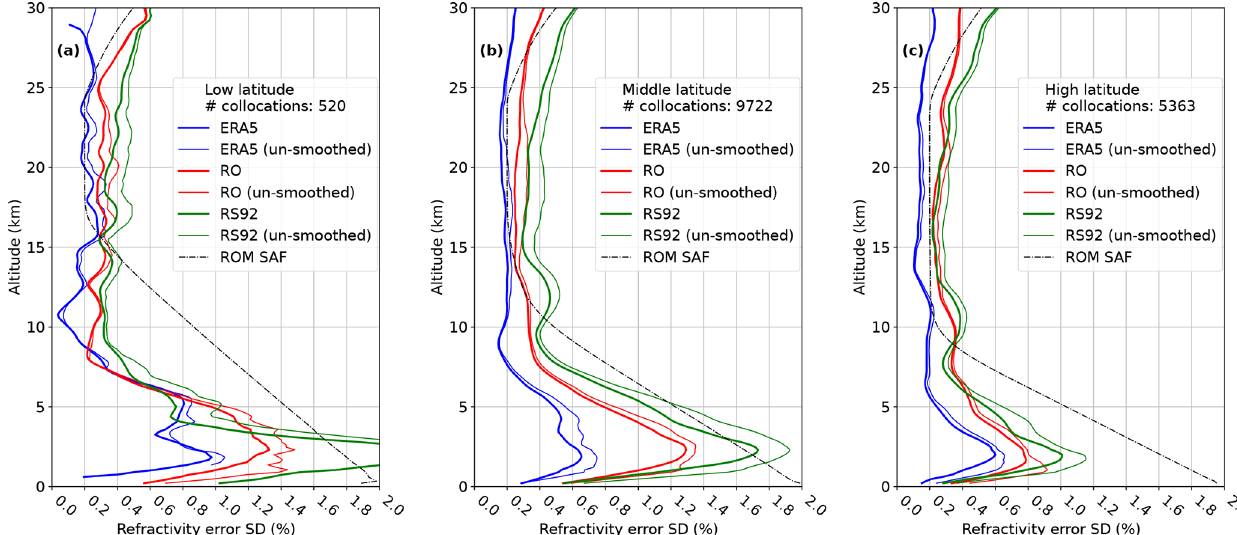
Figure 10. Best estimate of refractivity uncertainties, shown as standard deviations in percent of the ERA5 refractivity for ERA5, RO, and RS92 at low (a) , middle (b) , and high (c) latitudes. For all data sets the uncertainty is given with reference to the ERA5 vertical footprint, which is achieved by filtering all data sets to match the ERA5 vertical footprint (thick curves). The uncertainties based on un-smoothed data are also shown (thin curves). The standard deviation estimates found have been vertically smoothed with a 10 grid points box filter.